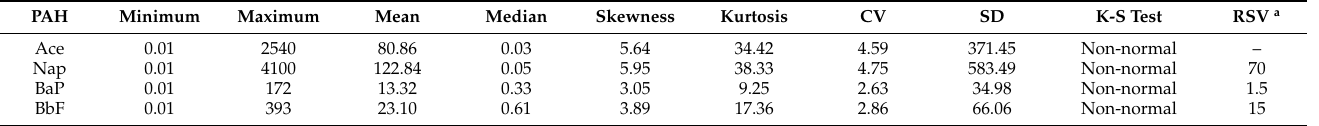
Table 1. Summarized statistics of the raw soil PAHs concentrations (Unit: